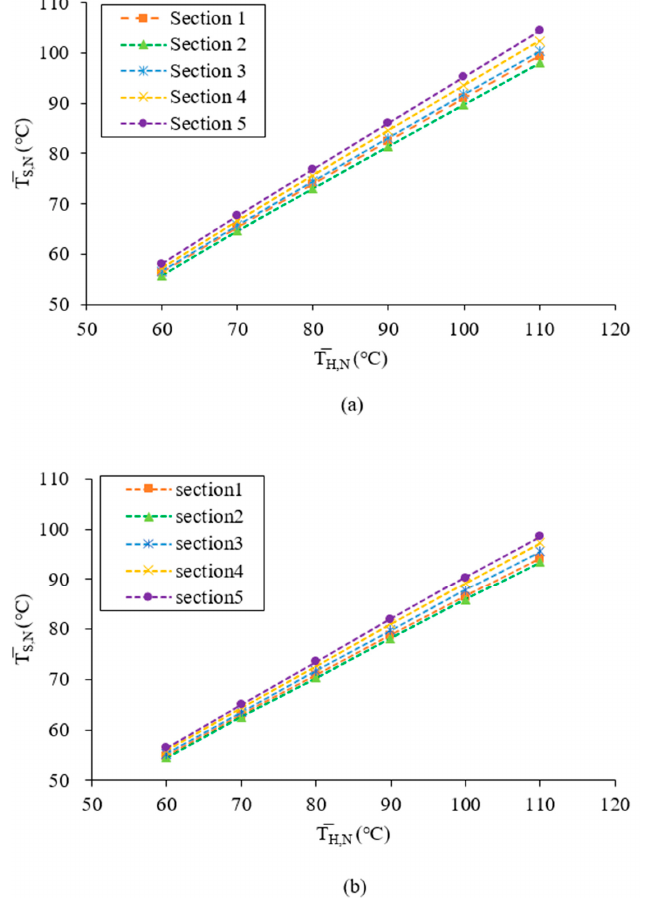
Figure 3. Obtained formula between heat panel temperature and top surface temperature of the spar-cap: ( a ) aluminum mold; ( b ) GFRP mold. The governing equation for numerical analysis of heat transfer is a complex heat transfer consisting of heat conduction, convection, and radiation. The heat transfer simulation is performed by Equations (2)–(3) and (5)–(6). Equation (2) is a typical equation used to calculate the heat conduction inside the material. This calculates the heat conduction from the heat panel to the spar-cap top face. Thermal conductivity 𝑘 , specific heat 𝐶 , and density 𝜌 are thermophysical properties of the material, and 𝑒(cid:4662) (cid:3034)(cid:3032)(cid:3041) is the amount of heat generated from the heat panel. Assuming a heat panel is a volumeless surface, 𝑒(cid:4662) (cid:3034)(cid:3032)(cid:3041) is defined as heat [ W/m (cid:2870) ]. ∇ (cid:2870) 𝑇 + (cid:3032)(cid:4662) (cid:3282)(cid:3280)(cid:3289) (cid:3038) = (cid:3038) (cid:3004)(cid:3096)(cid:3105)(cid:3021) (cid:3105)(cid:3047)